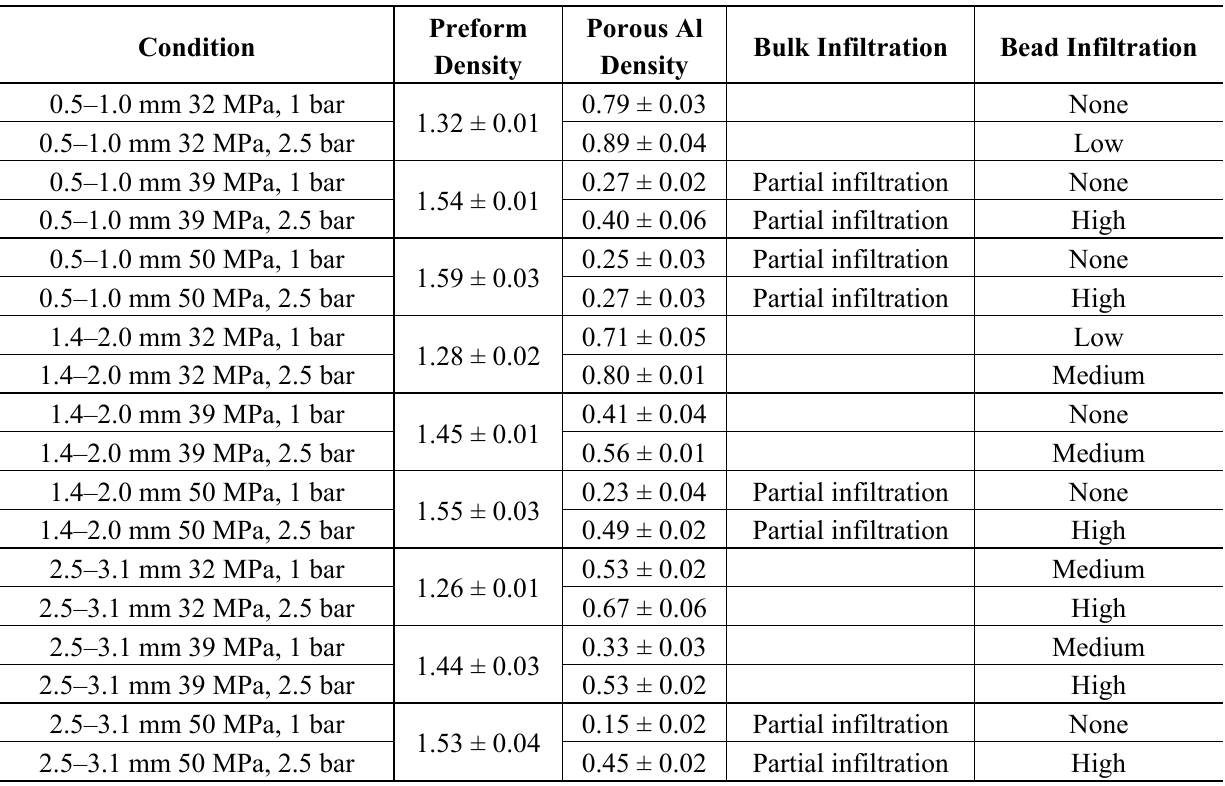
Table 1. Summary of the preform density data (in g/cm 3 ) and densities for the resultant porous Al